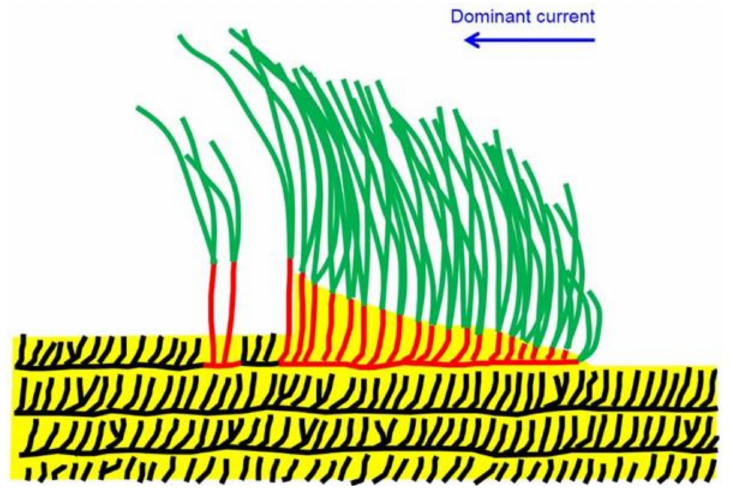
Figure 5. A cross-section within a strip of striped meadow. The progression is made toward the right by a plagiotropic (horizontal) rhizome, whereas the strip is eroded on the left by the hydrodynamism (generated by the dominant current). Black: dead rhizomes; red: live rhizomes; green: leaves; yellow: